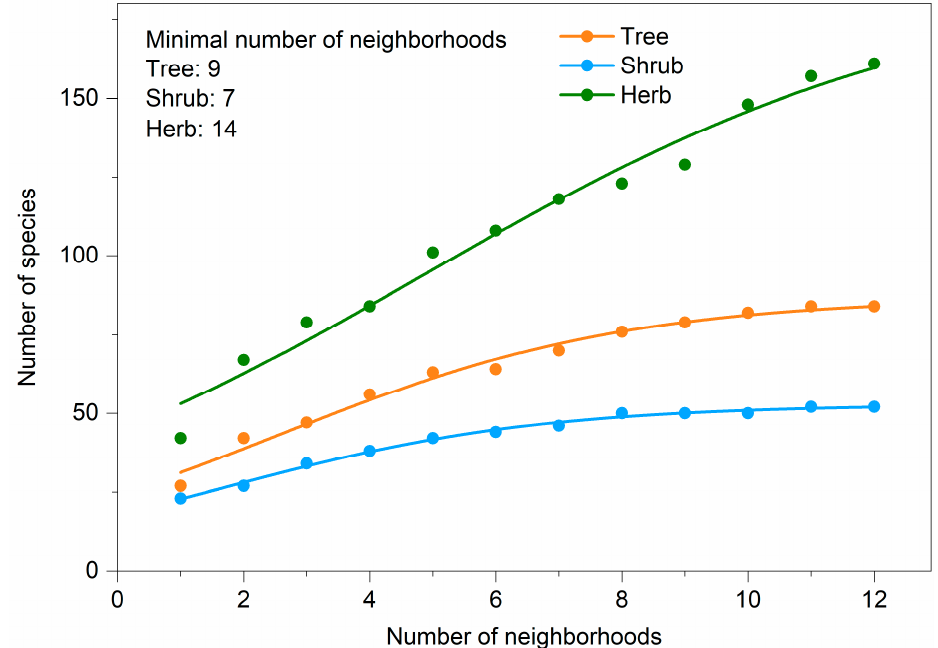
Figure 5. Number of species—number of neighborhoods accumulation curves based on logistic function. Adjusted R 2 for all curves was more than 0.97. F value for all curves was extremely significant.